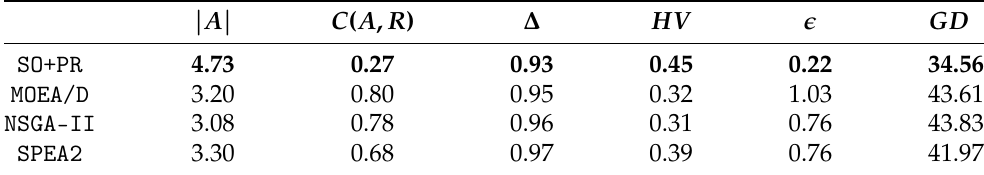
Table 6. Average results for k -BLC 12 on the pmed